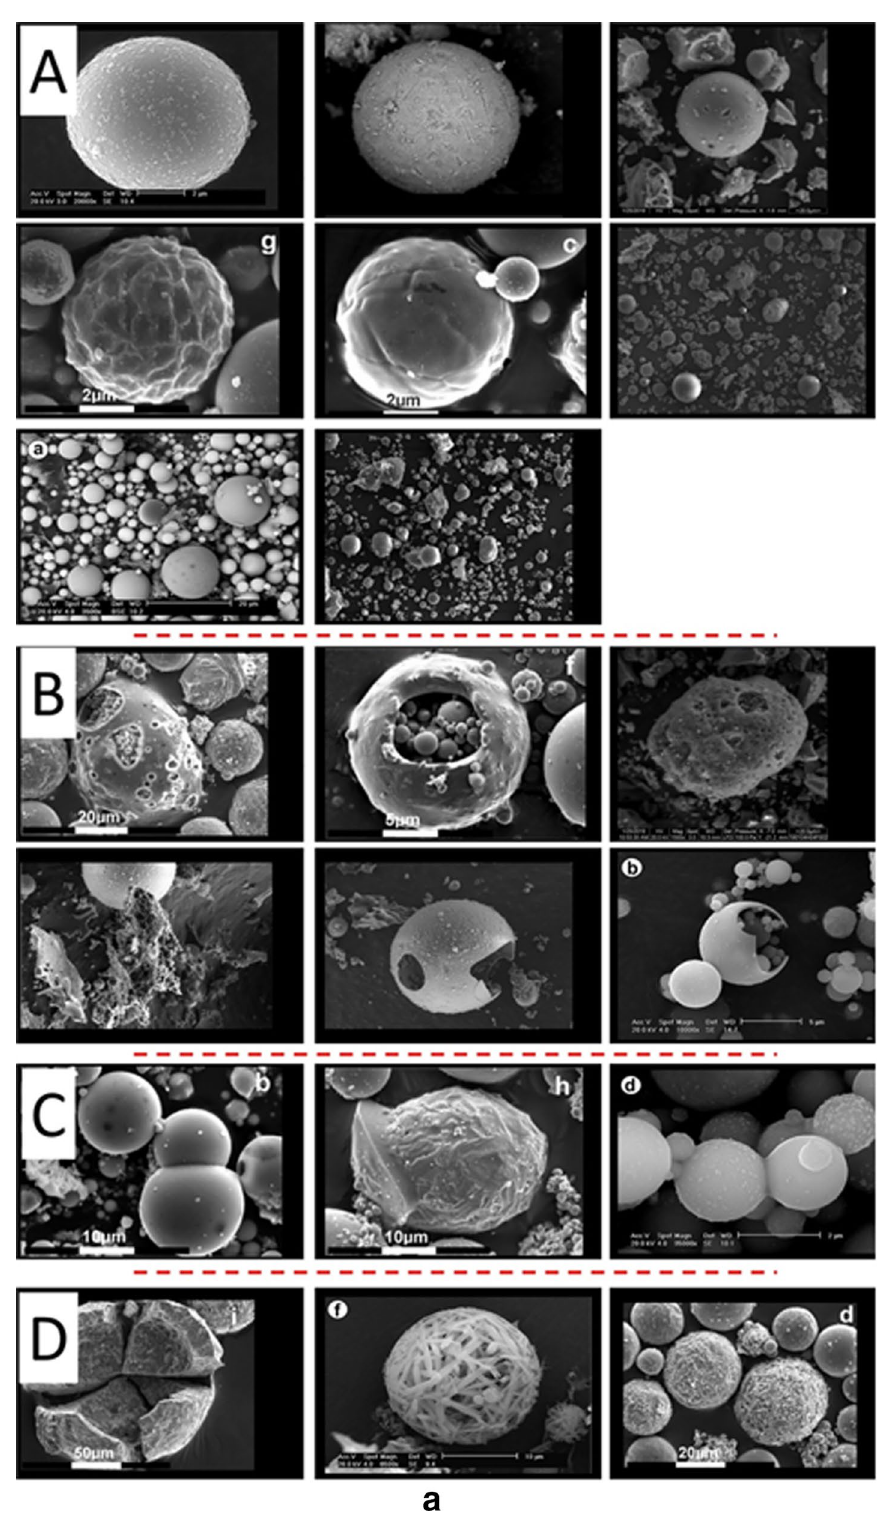
Fig. 5 a CFA with spherical shape (Brown et al. 2011; Rubio et al. 2008; Sow et al. 2015); b CFA with oval shape (Brown et al. 2011; Sow et al. 2015); c CFA particle with Irregular shape (Sow et al.